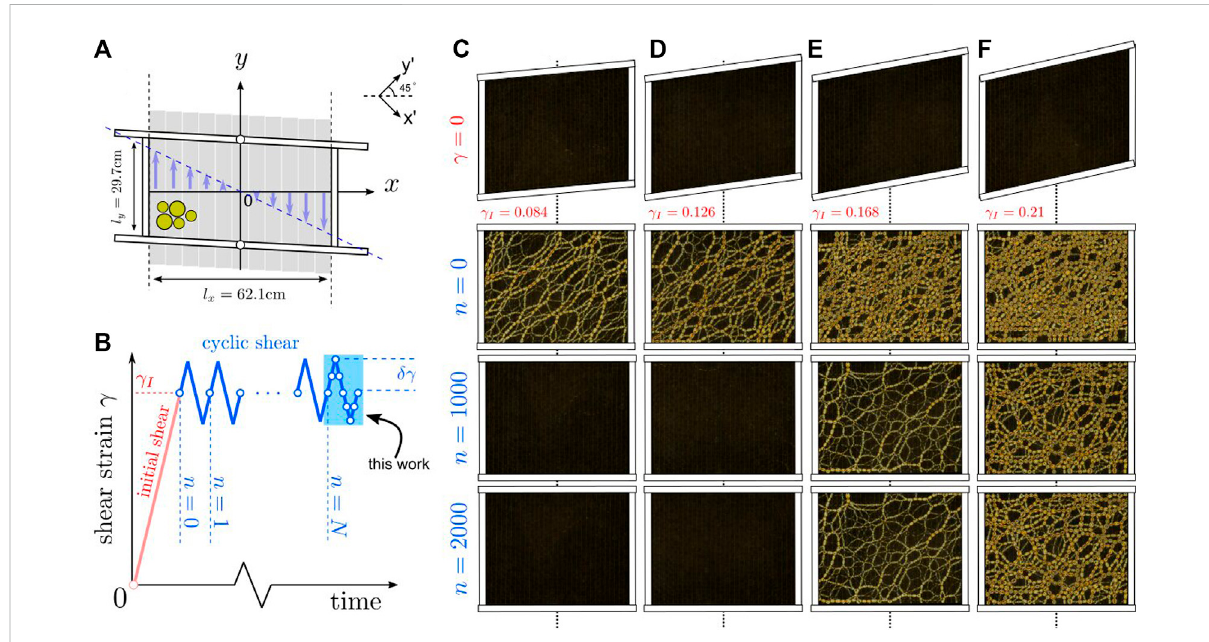
FIGURE 1 Experimental protocol and the ultrastable states. (A) A schematic top view of the multi-slat shear cell. Bottom slats move together with boundary walls to impose a uniform simple shear pro fi le. (B) The applied strain as a function of time. An initial large forward shear is followed by multiple periods of small-amplitude cyclic shear. The shear rate is always in the quasistatic regime. The light blue rectangle indicates the period of interest for the present work. Open circles schematically indicate the times of data snapshots. Both (A) and (B) are adapted from Ref. [1] (C – F) Snapshotsoftheforcechainnetworkforfourindependentrunswithdifferent γ I .Eachcolumnshowsimagesintheoriginalcon fi guration, theshear- jammed con fi guration following the initial forward shear, and the con fi gurations reached after 1000 and 2000 shear cycles. As indicated by the shapes of the original con fi gurations, the initial forward shear used to reach the rectangular con fi guration increases from left to right. All systems in (C – F) have same packing fraction ϕ =0.816, and the amplitudes of the cyclic shear are the same δγ =0.95%. The images are taken through a polariscope and thus only particles that bear fi nite stress are visible. Two ultrastable states are formed in (E) and (F) as the system locks in jammed states that do not change over at least a thousand shear